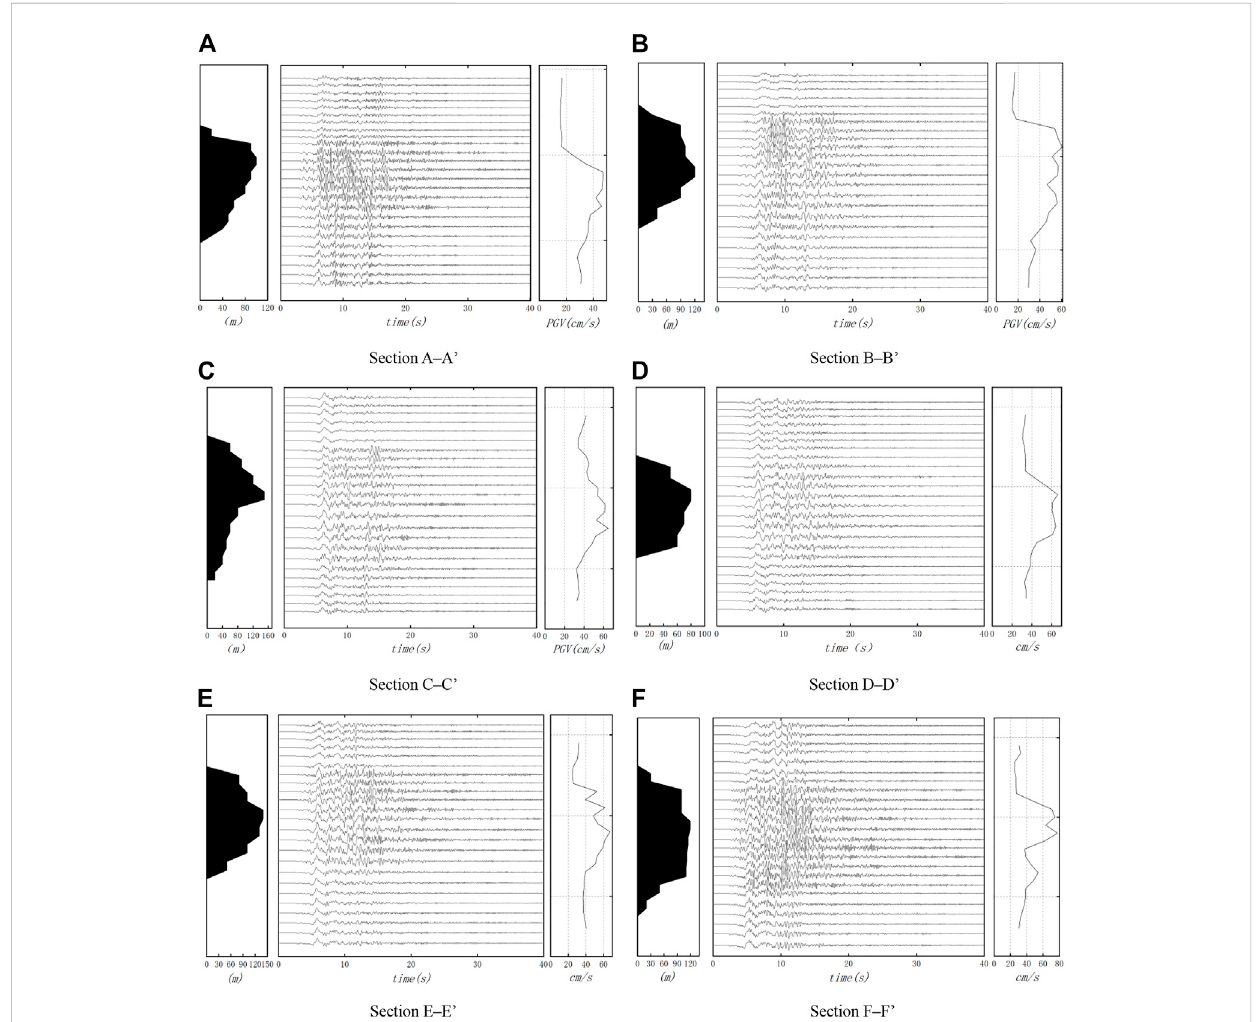
FIGURE 7 Ground motion time history. Thickness of the deposit (left, black area) corresponding to the observation points on sections A – A ′ to F – F ′ , velocity timehistoriesattheobservationpoints(middle),andthePGVatthesurfaceofeachsection(right). (A) SectionA – A ’ ; (B) SectionB – B ’ (C) SectionC – C ’ ; (D) Section D – D ’ ; (E) Section E – E ’ ; (F) Section F – F ’